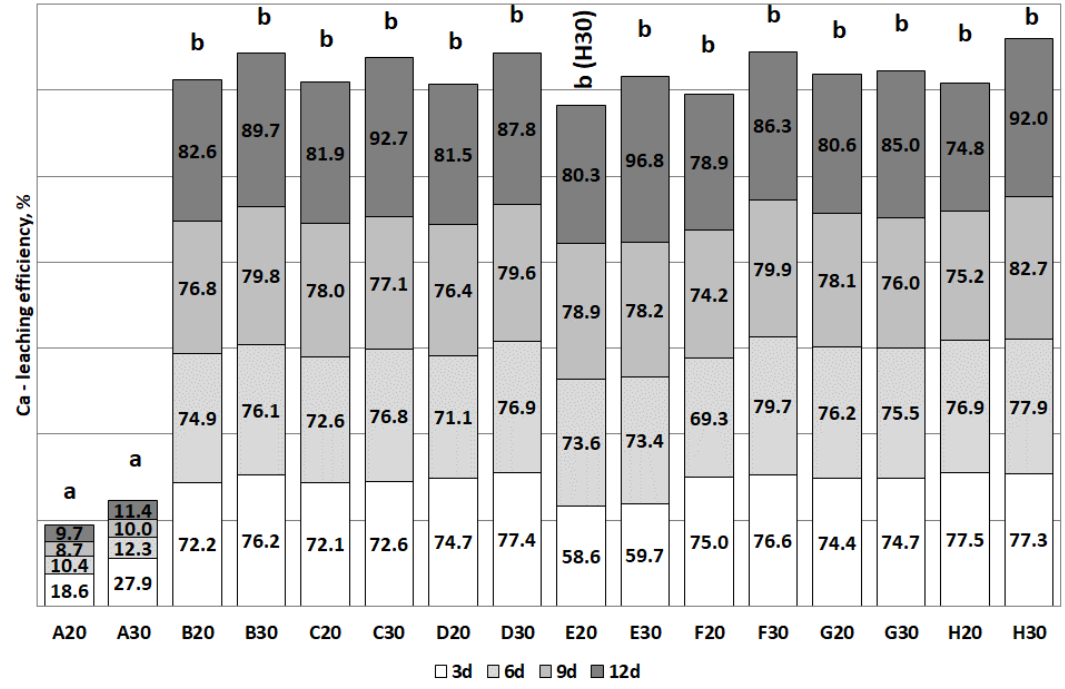
Figure 7. Bioleaching efficiency of Ca during the experiment (Statistical groups a and b ).